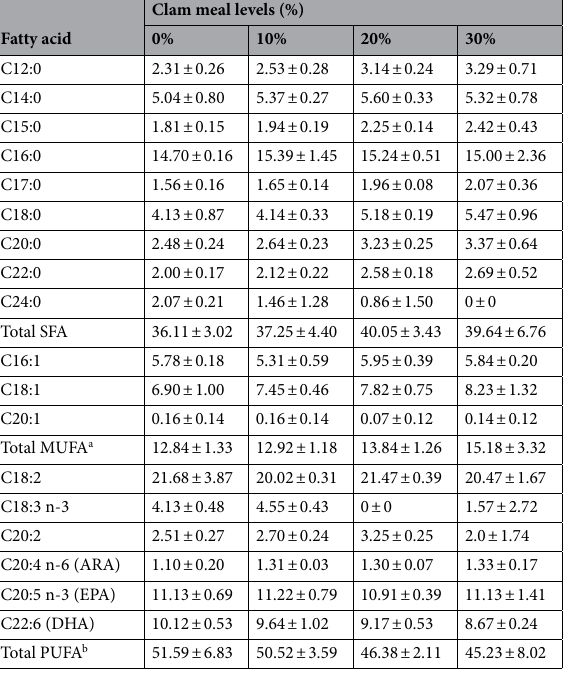
Table 3. Fatty acid compositions of diets. Relative percentages of fatty acids (mean ± SD) in diets (control or 0% CM, 10% CM, 20% CM, and 30% CM) fed to Florida pompano ( T. carolinus ) juveniles for 12 weeks. a Sum of monounsaturated fatty acids (MUFA) includes C20:1 for which the percentages are ≤ 0.2% of total fatty acids. b Sum of polyunsaturated fatty acids (PUFA) includes C18:3 n-6, and C20:3, for which the combined percentages are ≤ 0.5% of total fatty